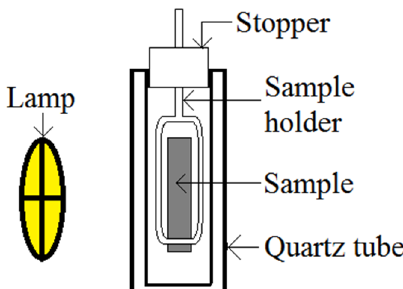
Figure 9. Schematic diagram of the photocatalytic reactor in which photocatalytic degradation was performed.